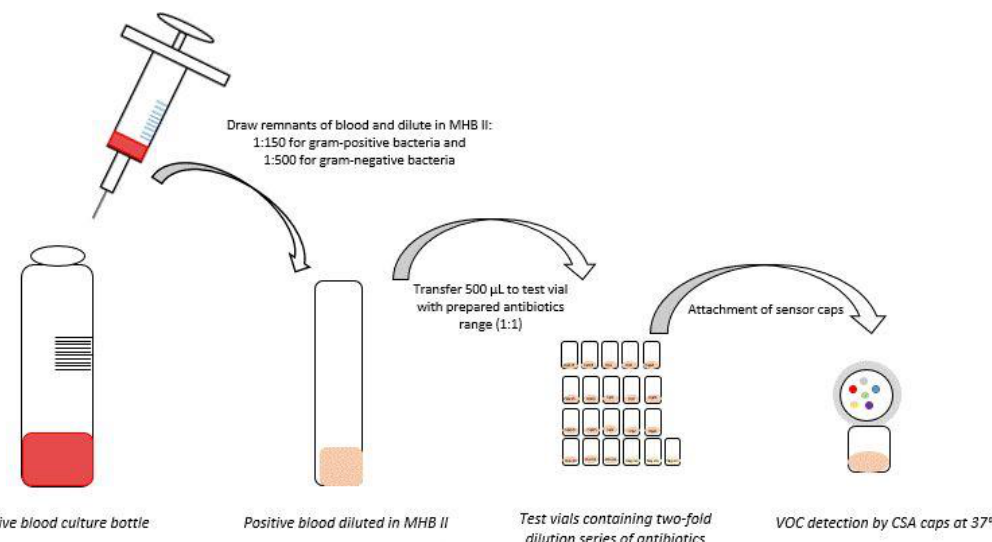
Figure 2. Sample preparation for SpecifAST ® testing MHB II: Muller Hinton II Broth; CSA: Colori- metric sensor array; VOC: Volatile organic compounds.